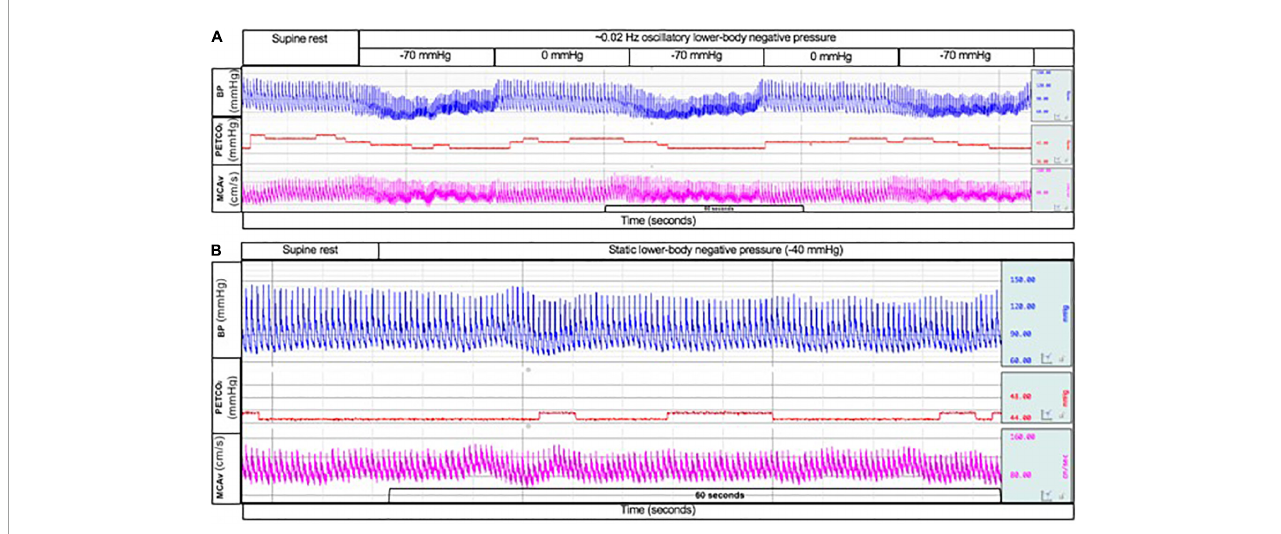
FIGURE1 Typical tracing of beat-to-beat blood pressure (top; blue line), end-tidal CO 2 tension (middle; red line), and middle cerebral artery blood velocity (bottom; pink line) during oscillatory lower-body negative pressure at –70 mmHg and 0 mmHg (A) and during static lower-body negative pressure at –40 mmHg (B) .